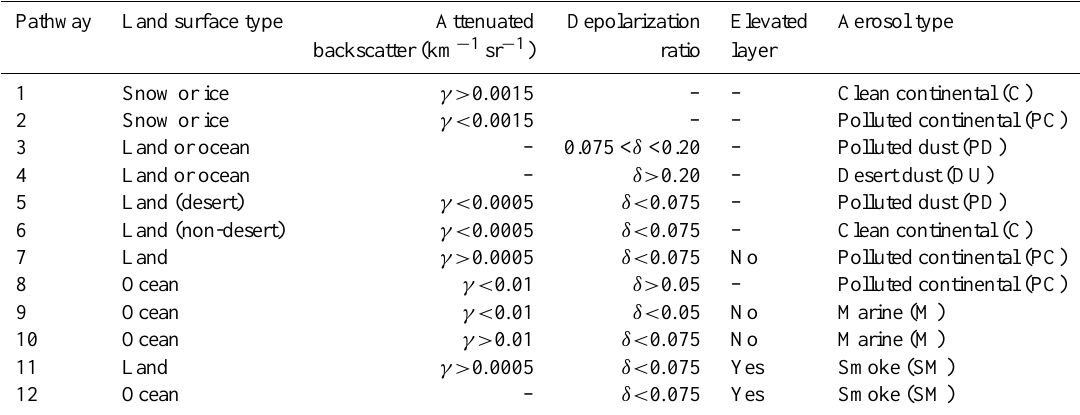
Table 1. CALIOP VFM mapping algorithm presented in table form. We refer for Omar et al. (2009) for an algorithm flowchart. “–” indicates that the property of an aerosol layer is not considered in assigning aerosol